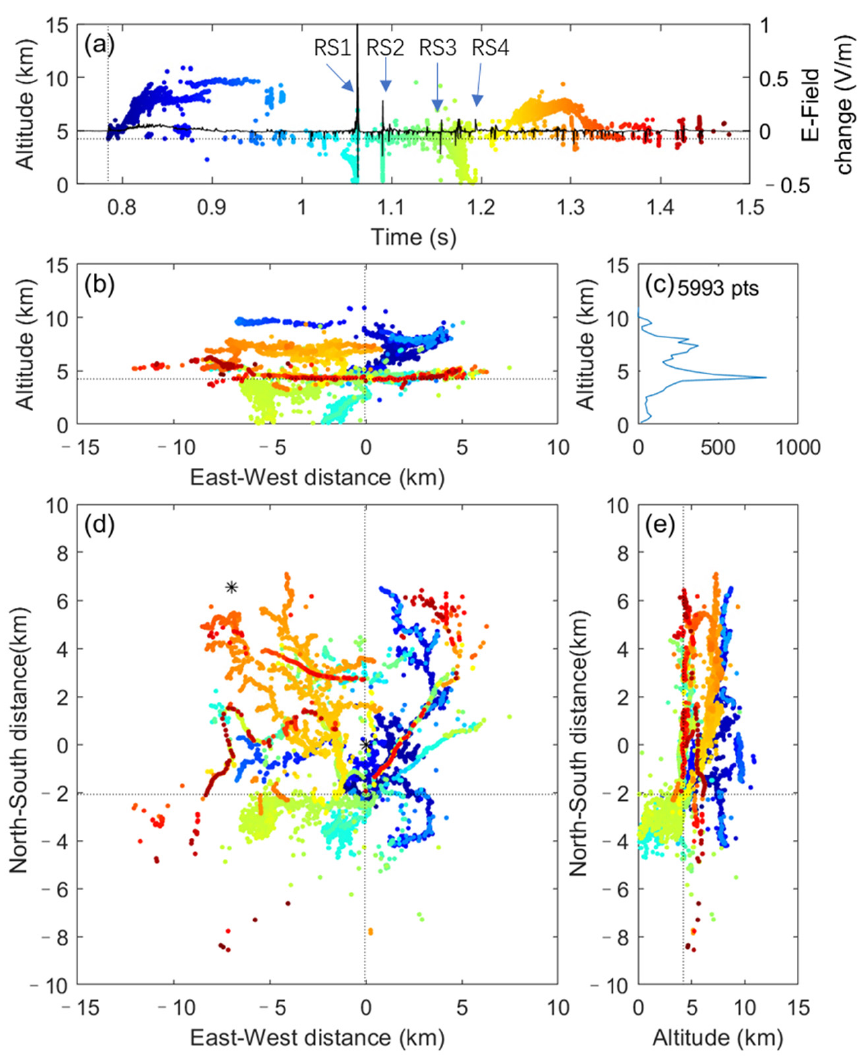
Figure 8. Three-dimensional location results of the CG lightning flash. ( a ) height with time, ( b ) north–south vertical projection, ( c ) height distribution of the number of radiation sources, ( d ) plane projection, and ( e ) east–west vertical projection of the three-dimensional location result. Asterisks are positions of the interferometer. Dashed lines intersect at the initiation point of the flash.